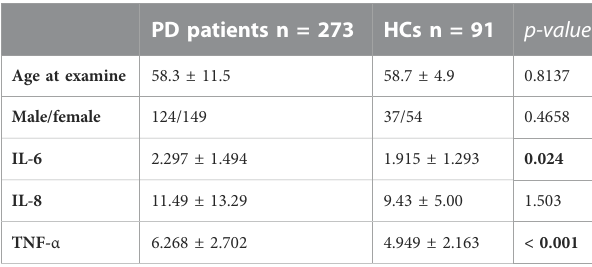
TABLE 1 Comparison of peripheral immune variables in PD patients and matched controls.